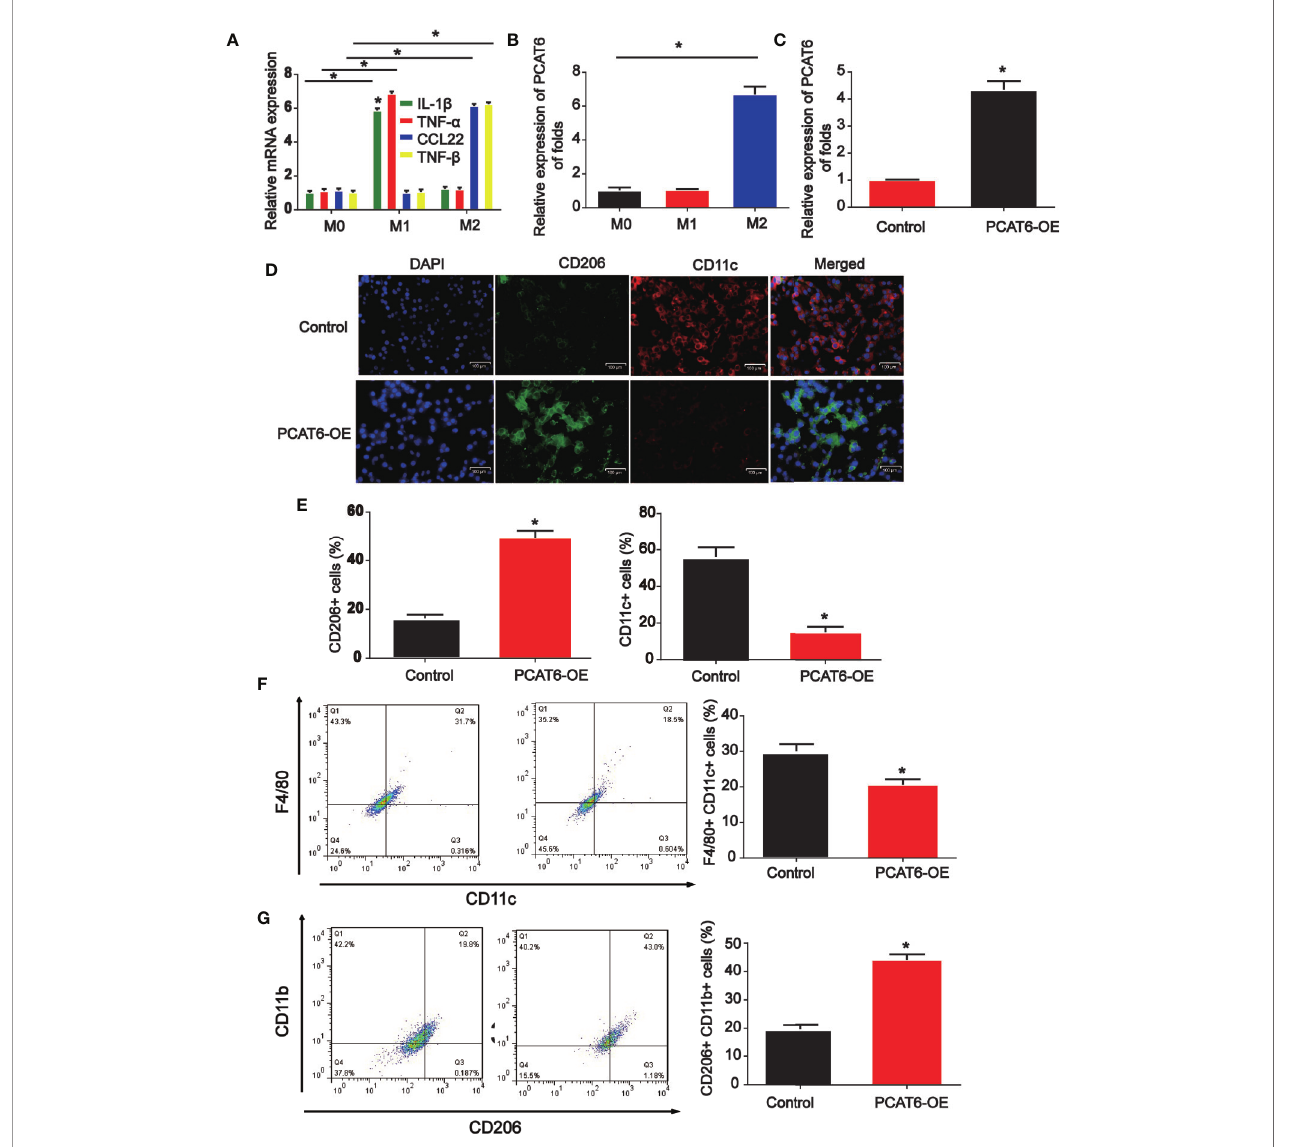
FIGURE 3 | The effect of PCAT short hairpin RNA (shRNA) on M2-like polarization of macrophages. (A) Levels of M1 and M2-associated makers were determined in THP-1-diferentiated macrophages. (B) RNA was extracted from M1 and M2 and levels of lncRNA PCAT6 was determined using RT-qPCR in THP-1-diferentiated macrophages. (C) The ef fi ciency PCAT6-OE was con fi rmed using qRT-PCR analysis. (D, E) Control and PCAT6-overexpressed macrophages were analyzed by immuno fl uorescence with CD206 and CD11c antibodies. Scale bar, 100 m m. (F) The control and PCAT6-overexpressed macrophages were analyzed by fl ow cytometry with M1 markers (CD11c and F4/80). (G) The control and PCAT6-overexpressed macrophages were analyzed with M2 markers (CD206 and CD11b). *P < 0.05. Compared with the control